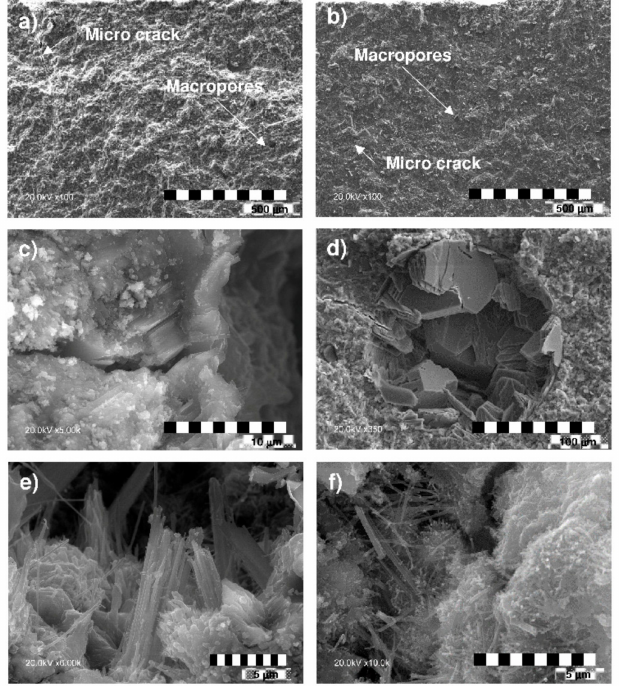
Figure 6. SEM micrographs of the compounds formed in cement pastes after 180 days exposure to 0.3 M Na 2 SO 4 : ( a ) OPC; ( b ) OPC + 20 BA; gypsum plates in ( c ) OPC and ( d ) OPC + 20 BA; and ettringite needles in ( e ) OPC; ( f ) OPC + 20